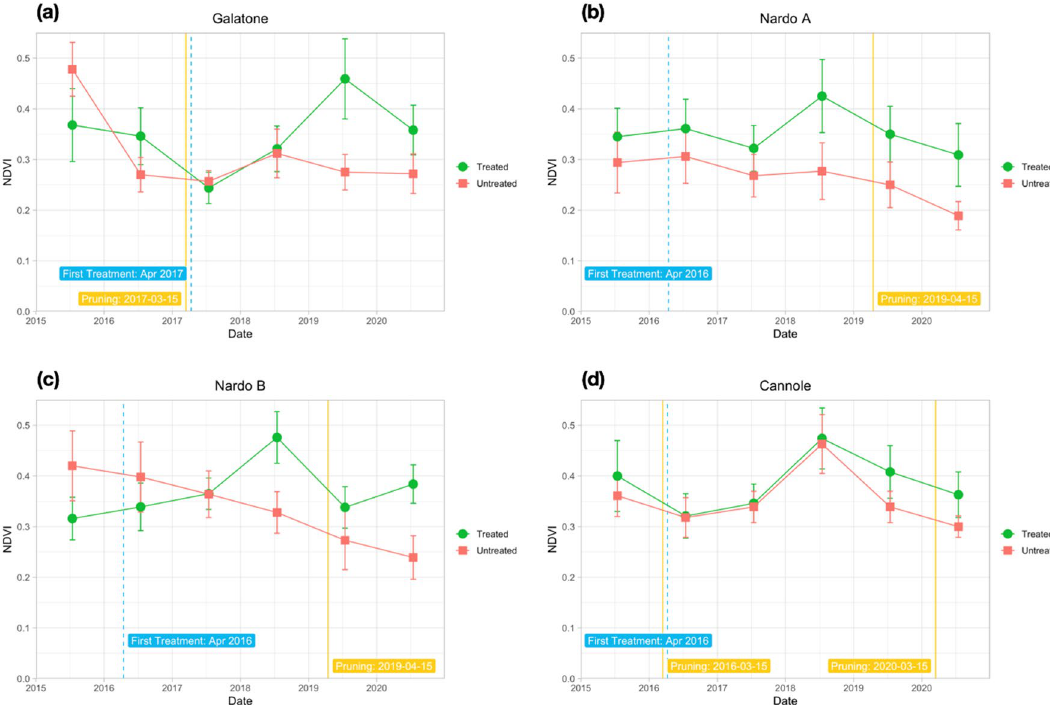
Figure 4. S-2 NDVI trend from each experimental field with or without restoration treatment. ( a ) Galatone; ( b ) Nardò A; ( c ) Nardò B; ( d ) Cannole. Starting of the restoration treatment and pruning dates are indicated. Fields